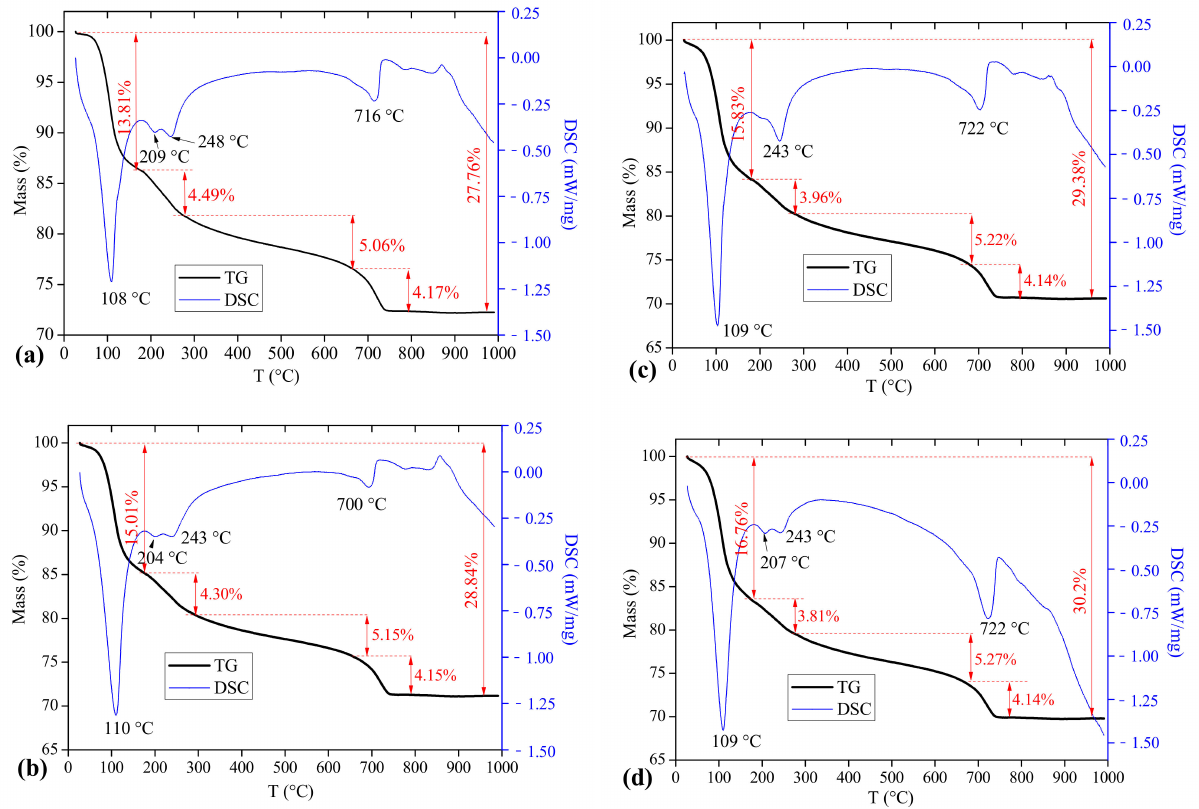
Figure 8. TG-DSC curves of CSAC-GGBFS mixtures with different FGDG content hydrated for 120 d. ( a ) 0%, ( b ) 3%, ( c ) 6% and ( d ) 9%.